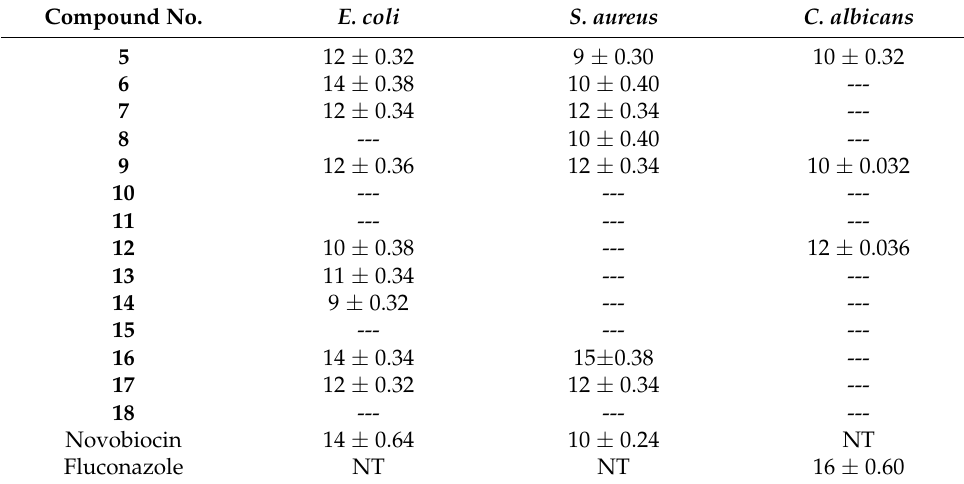
Table 4. Antimicrobial activity of compounds 5 – 18. Compound